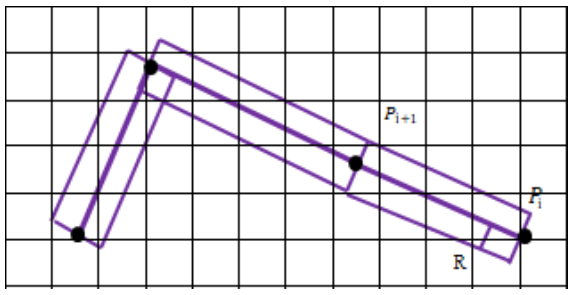
Figure 8. Schematic diagram of buffer and grid settings.